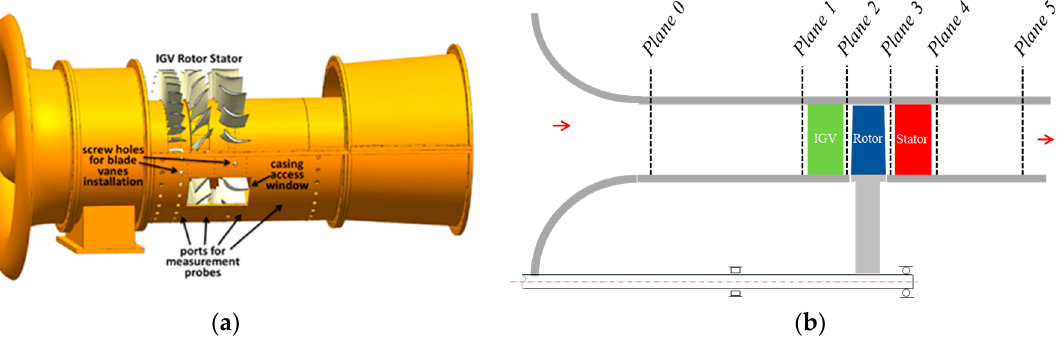
Figure 3. Schematics of the LSLSAC. ( a ) Geometry configuration; ( b ) measurement locations.